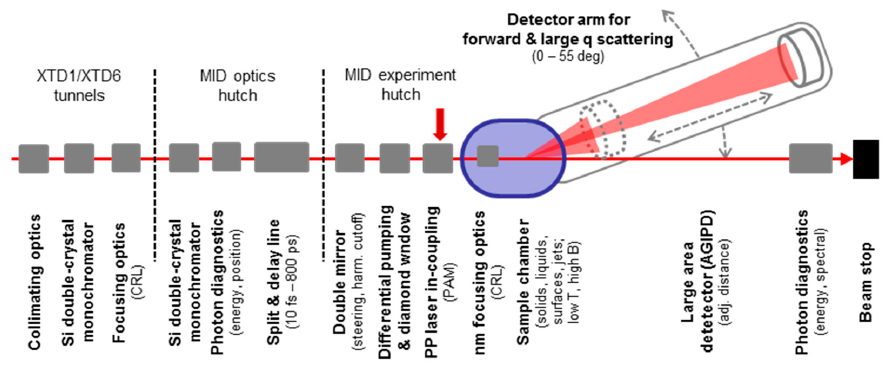
Figure 8. Schematic outline of the MID scientific instrument at the SASE2 FEL. Shown are major instrumentation items installed in the photon beam transport tunnel, optics hutch and experiment hutch comprising the beam transport, focusing and diagnostic devices.